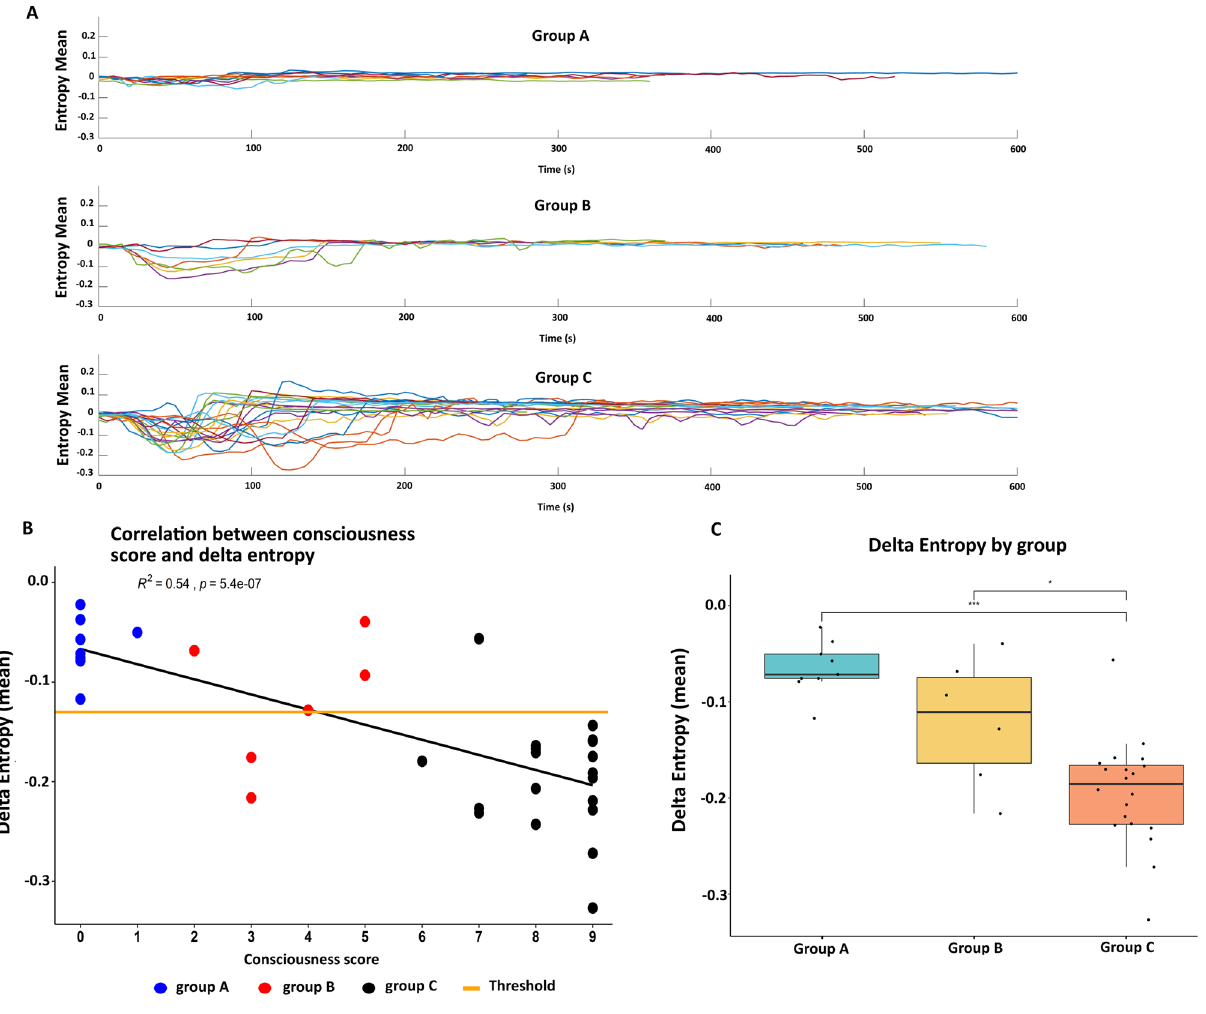
Figure 2. Visualization of the entropy changes by consciousness groups (Group A, B, C). ( A ) Mean entropy values averaged from all channels for all the seizures in each group. ( B ) Correlation between consciousness scores and mean delta entropy value with the threshold determined by ROC curve to differentiate Group C and Group A (threshold in orange at − 0.135) ( C ) Distribution of the delta entropy values according to each group. * p < 0.05 *** p <